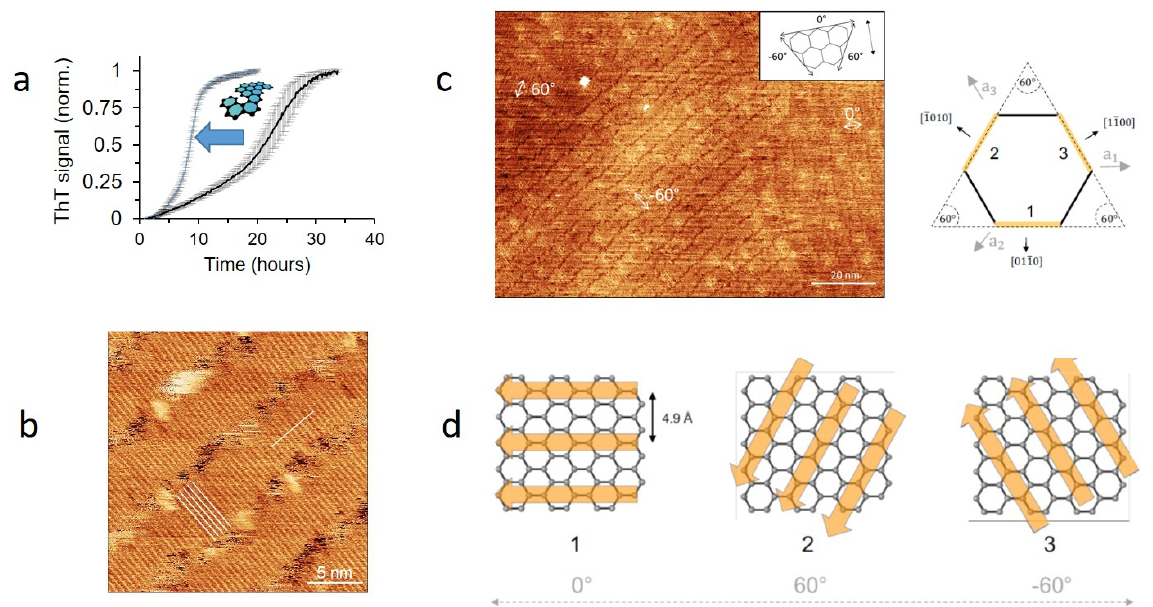
Figure 9. Effect of a structured surface on CsgA self-assembly. ( a ) Graphite nanoparticles promote aggregation of CsgA in vitro. ( b ) STM image of full-length CsgA deposited on HOPG. The five parallel white bars in the lower left corner highlight adjacent β -strands; the orthogonally placed white bar in the upper right corner measures the average distance over 10 strands to be ca. 4.8 Å. ( c ) STM image illustrates the 3 preferred orientations of full-length CsgA on HOPG (angles illustrated in the insert) and their orientation relative to the HOPG orthogonal structure. ( d ) The positions of individual strands in these arrangements are dictated by the orientation of the graphene atoms and lead to a strand distance of 4.9 Å. Adapted from [157].